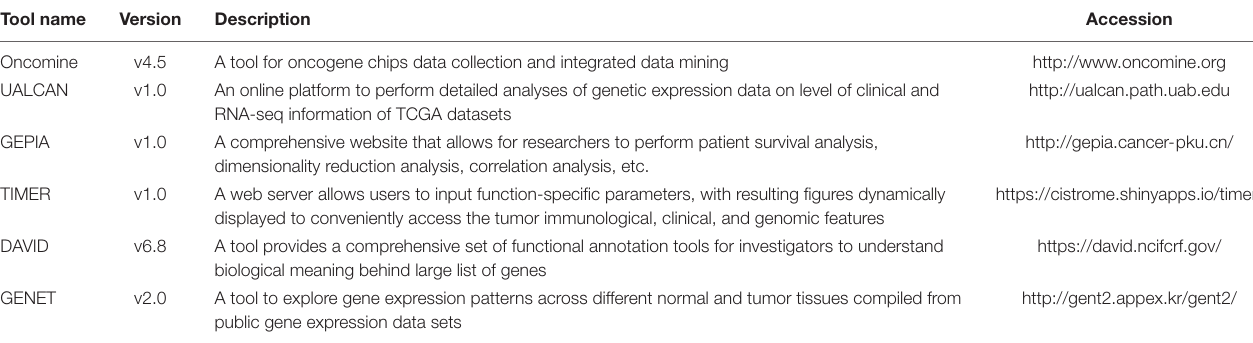
TABLE 3 | The detail information of tools used in our analysis